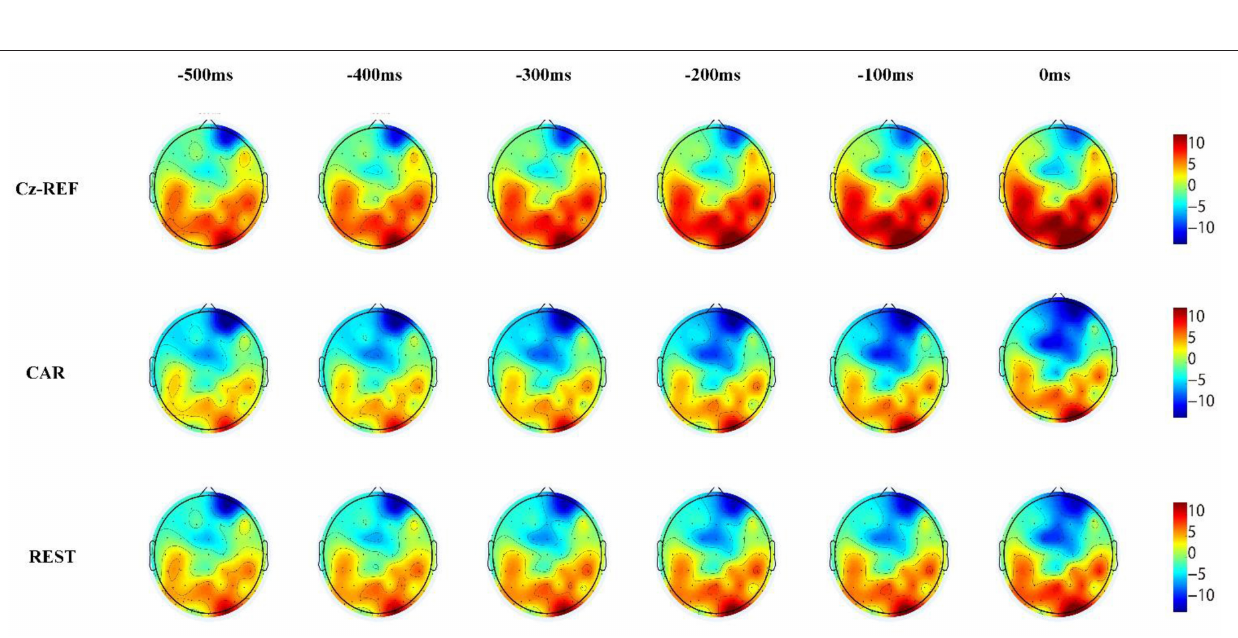
FIGURE 6 | Voltage topographies of S7’s left hand movement RP in three references.